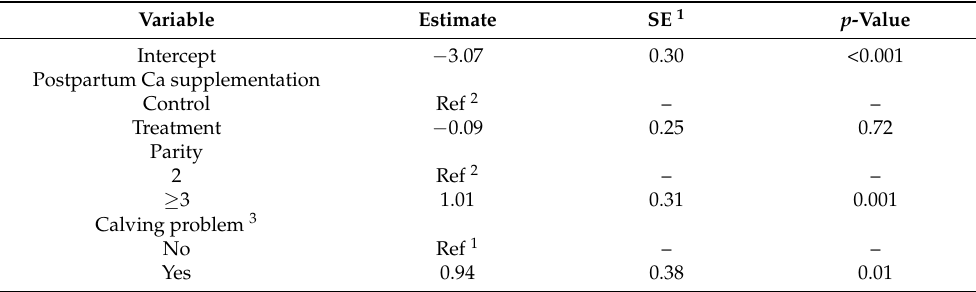
Table 3. Final logistic regression model evaluating the effect of an oral postpartum calcium supple- mentation strategy with culling in the first 60 DIM in a randomized clinical trial in multiparous Jersey cows ( n = 809) in a dairy in west